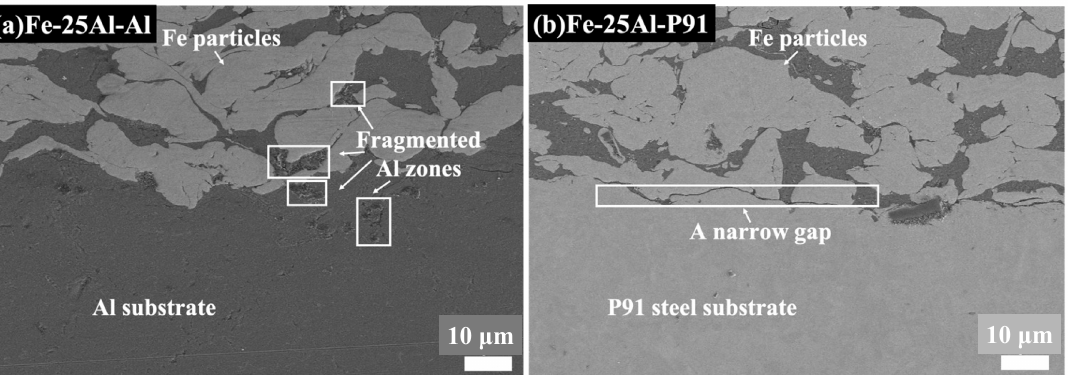
Figure 7. SEM images of Fe-25Al-Al and Fe-25Al-P91, in which fragmented zones appeared along the inter-particle interface and the coating/substrate interface in ( a ). A narrow gap existed along the coating/substrate interface in ( b ).